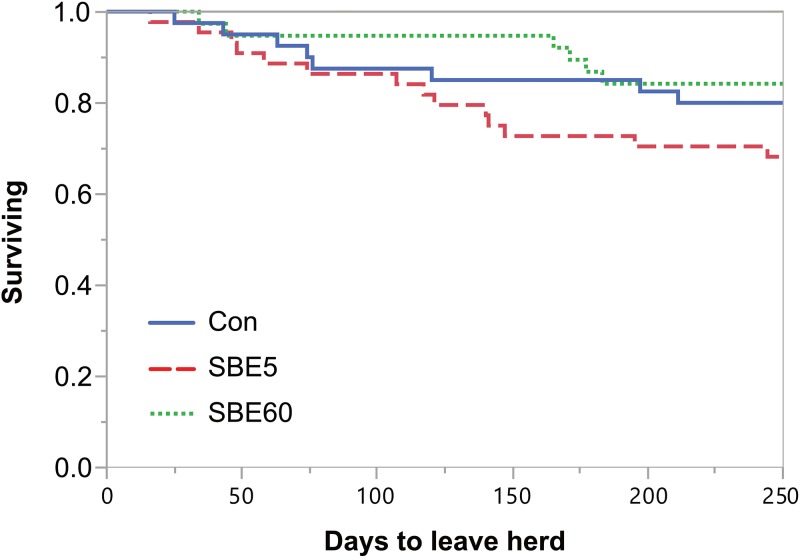
Surivival plot for time to leave the herd through 250 DIM.Data were right-censored at 250 d. The hazard of leaving the herd (cull or death) was not affected by treatment (P = 0.16). The hazard ratios for treatment comparisons were as follows: 1.85 (95% CI: 0.75–4.92) for SBE5 vs. Con and 0.72 (95% CI: 0.21–2.27) for SBE60 vs. Con.